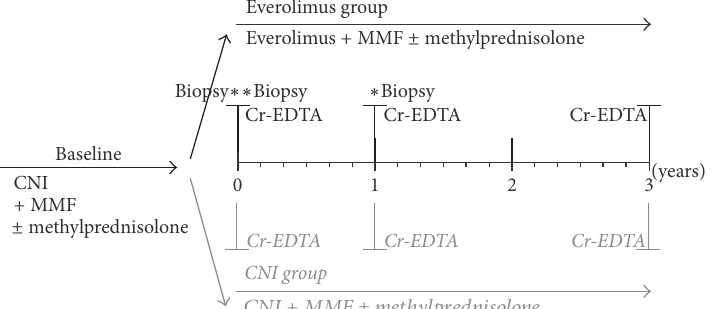
Figure 1: Study design. ∗ protocol myocardial biopsy; CNI, calcineurin inhibitor; MMF, mycophenolate mofetil; Cr-EDTA, mGFR measurement by Cr-EDTA